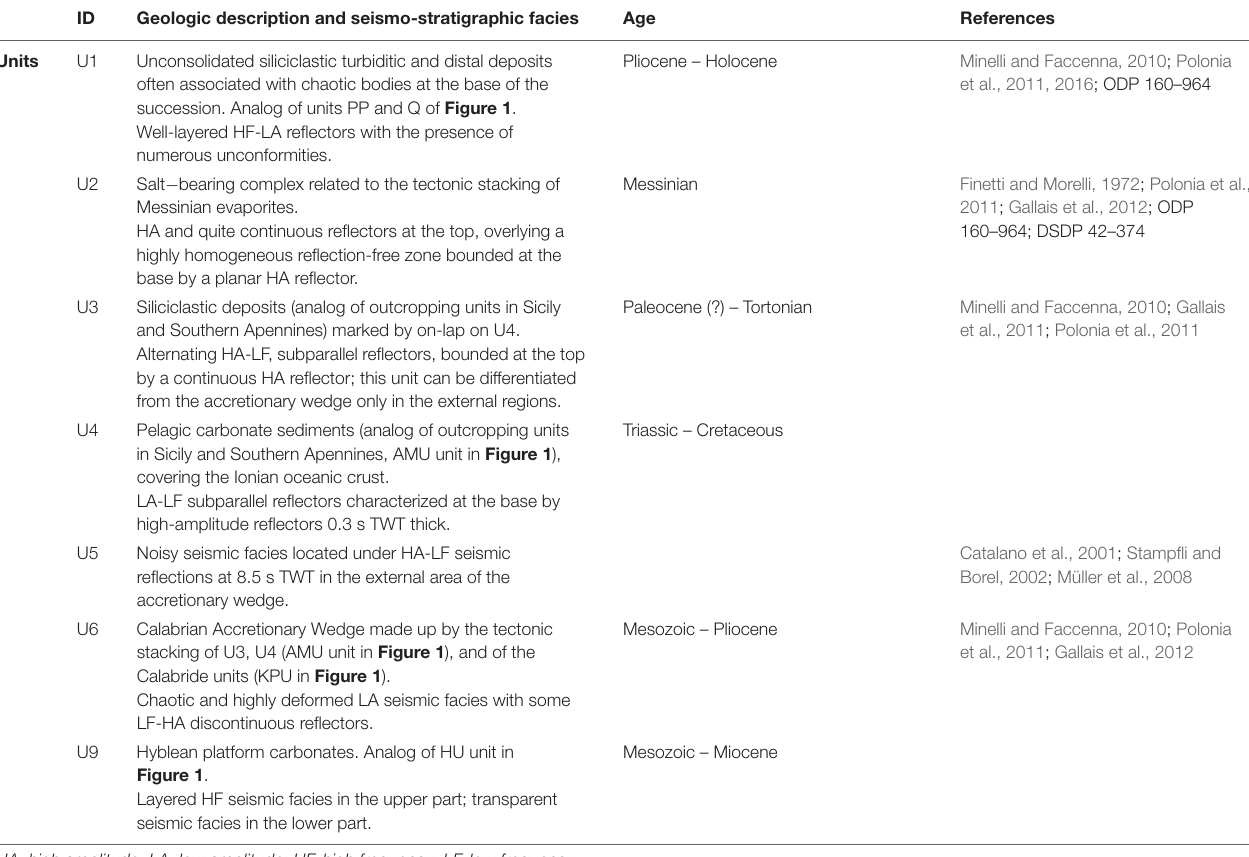
TABLE 2 | Seismo-stratigraphic units.